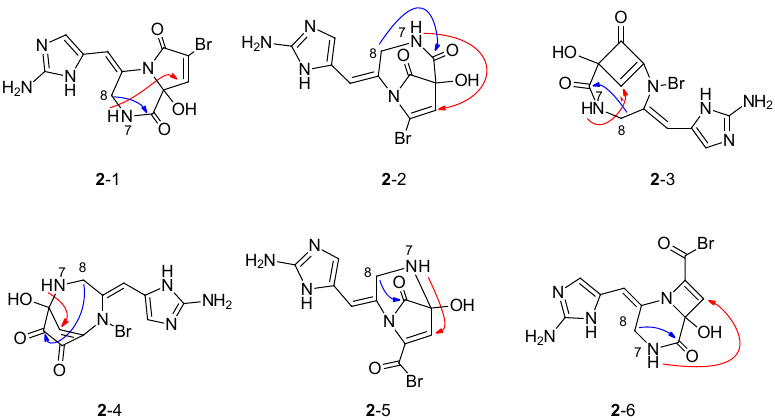
Figure 4. Constitutional proposals for oxocyclostylidol ( 2 ) generated by W EB C OCON . For the data set without 4 J correlations ( A0 ) and three data sets with one 4 J correlation ( B1 , D1 , and E1 ), four constitutions were found ( 2 -1, 2 -2, 2 -3, and 2 -6); for data set C1 , all six structures were generated. In the proposals 2 -4 and 2 -5, the 4 J -HMBC correlation H-7/C-3 (red arrows) was fulfilled as